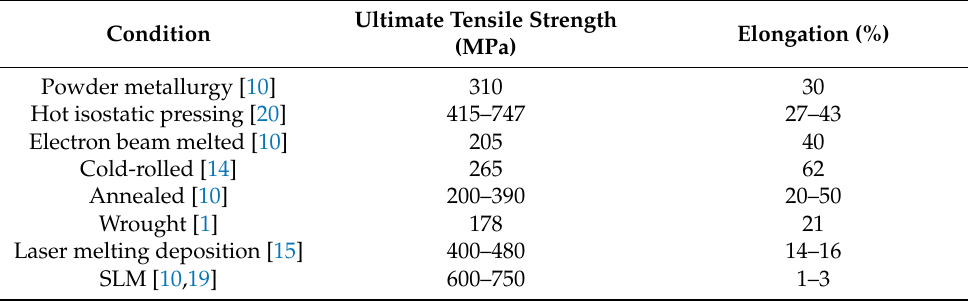
Table 1. Tensile properties of pure Ta fabricated by different processing techniques.